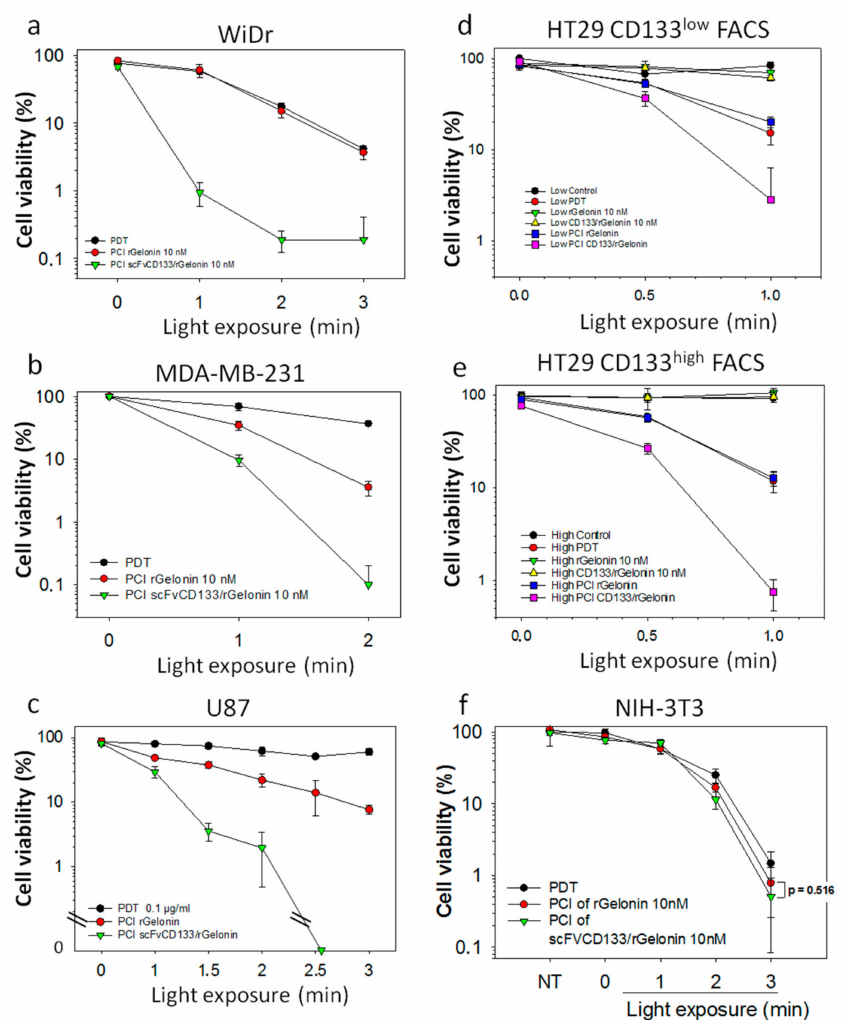
Figure 4. Light dose-dependent cytotoxic e ff ects of PCI of rGelonin versus PCI of scFvCD133 / rGelonin in cells with various expression of CD133. WiDr (( a ), CD133 high ), MDA-MB-231 (( b ), CD133 low ), U87 (( c ), CD133 low ), HT-29 (( d , e ), CD133 high ), and NIH-3T3 (( f ), CD133 neg ). Incubation set-up described in Section 2.9. The data are the mean of triplets within the experiments, which were reproduced at least twice. CD133 high ( d ) and low ( e ) sorted HT29 cells subjected to PCI of 10 nM rGelonin and scFvCD133 / rGelonin incubated for 2 h (Cntrl = untreated cells, PDT = TPCS 2a in combination with light, rGel = rGelonin). The data in ( f ) is representative of two independent experiments, while ( a – e ) data are representative of at least three individual experiments. Error bars =